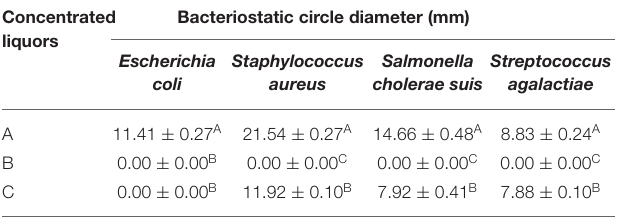
TABLE 1 | In vitro antibacterial effects of different fermented compound Chinese medicine feed additives. Concentrated